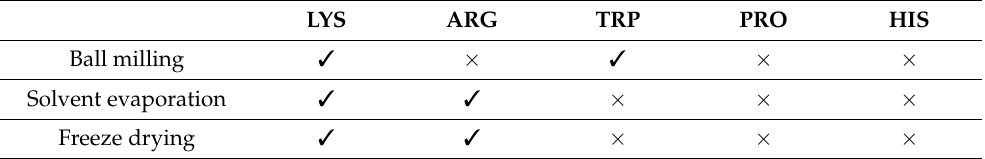
Table 3. The results of SA amorphization with amino acids in each preparation techniques. LYS ARG TRP PRO HIS Ball milling (cid:51) × (cid:51) × × Solvent evaporation (cid:51) (cid:51) × × × Freeze drying (cid:51) (cid:51) × × × The “ (cid:51) ” symbol indicates successful co-amorphization of SA with amino